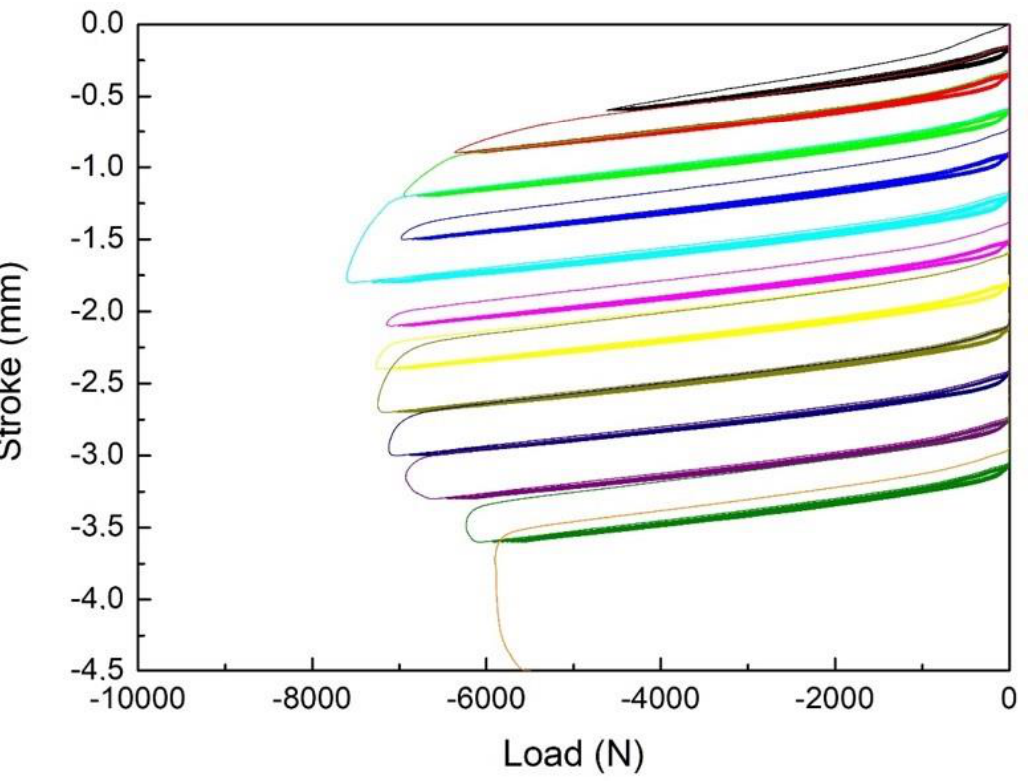
Figure 9. Cyclic bending curves performed at different maximum vertical deformation. Cracks were all located in the zone of maximum bending and maximum stress con- centration (the center of the notch), with the main central crack opening upon increasing the maximum load and the number of cycles. In our previous study [37], the coating duc- tility behavior under monotonic or cyclic bending was related to the number of cracks produced on the surface before the coating delamination. In the present case, the main crack nucleated in correspondence with the center of the notch for all maximum defor- mations imposed during tests. This was mainly due to the fact that cyclic loading led to the relaxation of residual stresses in the zone of maximum stress concentration. As a con- sequence, residual stresses decreased because the dislocations induced by cyclic loading converted the strain energy of macro residual strain into plastic strain. This took place overcoming a given critical value of the applied load, and its effect increased with the applied strain. Then, various cyclic tests were conducted at different constant maximum strokes, and the tests were interrupted in order to observe the appearance of the first crack, the number of cycles for this damage initiation was recorded per each test. The summary is shown in Figure 10 where the maximum stroke is plotted as a function of the number of cycles until the first crack appearance.